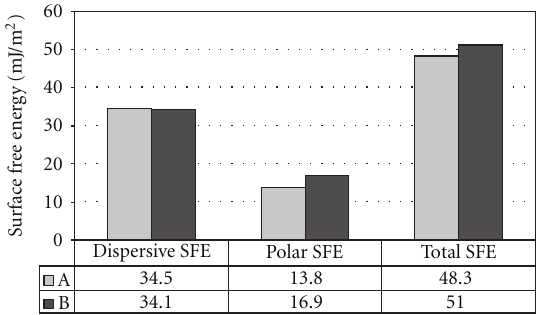
Figure 5: Dispersive ( γ D ), polar ( γ P ), and total ( γ TOT ) components of surface free energy (SFE) calculated using the Owens-Wendt approach: (A) in-plane distribution of fibers; (B) transverse distri- bution of fibers.